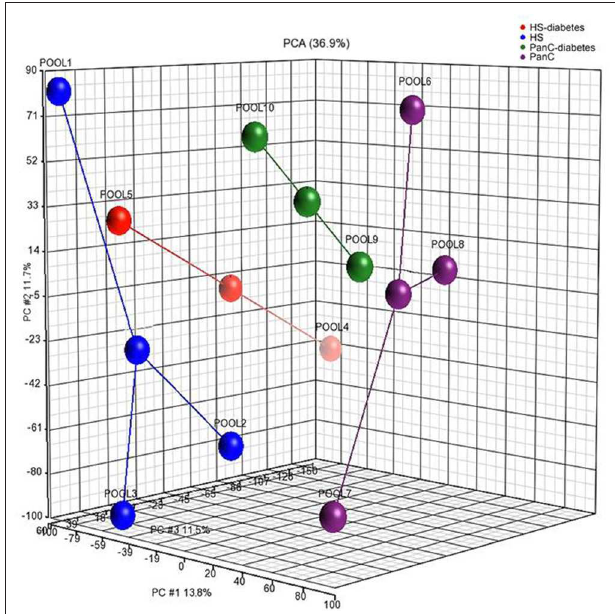
FIGURE 2 | Principal component analysis performed on miRNAs expression levels in pooled plasma samples from healthy subjects and pancreatic cancer patients. Healthy subjects were stratified according to the category of risk for pancreatic cancer development (blue circles: Pool 1 , Pool 2 , Pool 3 ), and to the date of diagnosis of diabetes (red circle: Pool 4 , Pool 5 ); patients with pancreatic cancer were classified based on the preoperative stage of the disease (purple circles: Pool 6 , Pool 7 , Pool 8 ), and on the date for patients diagnosis of diabetes (green circles: Pool 9 , Pool 10 ).